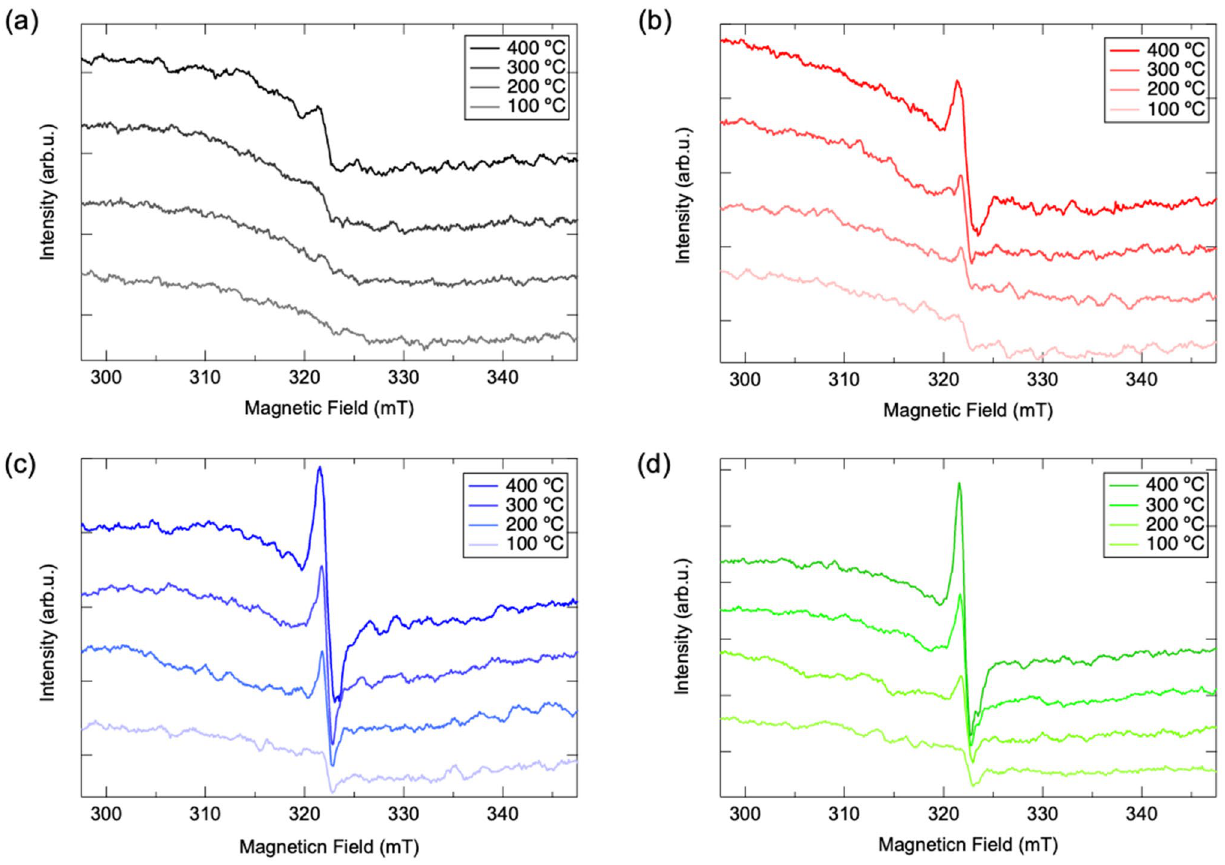
Figure 4. In-situ ESR spectra of ( a ) raw and mechanochemical treated HAp via ( b ) 3 mm, ( c ) 10 mm and ( d ) 15 mm under different